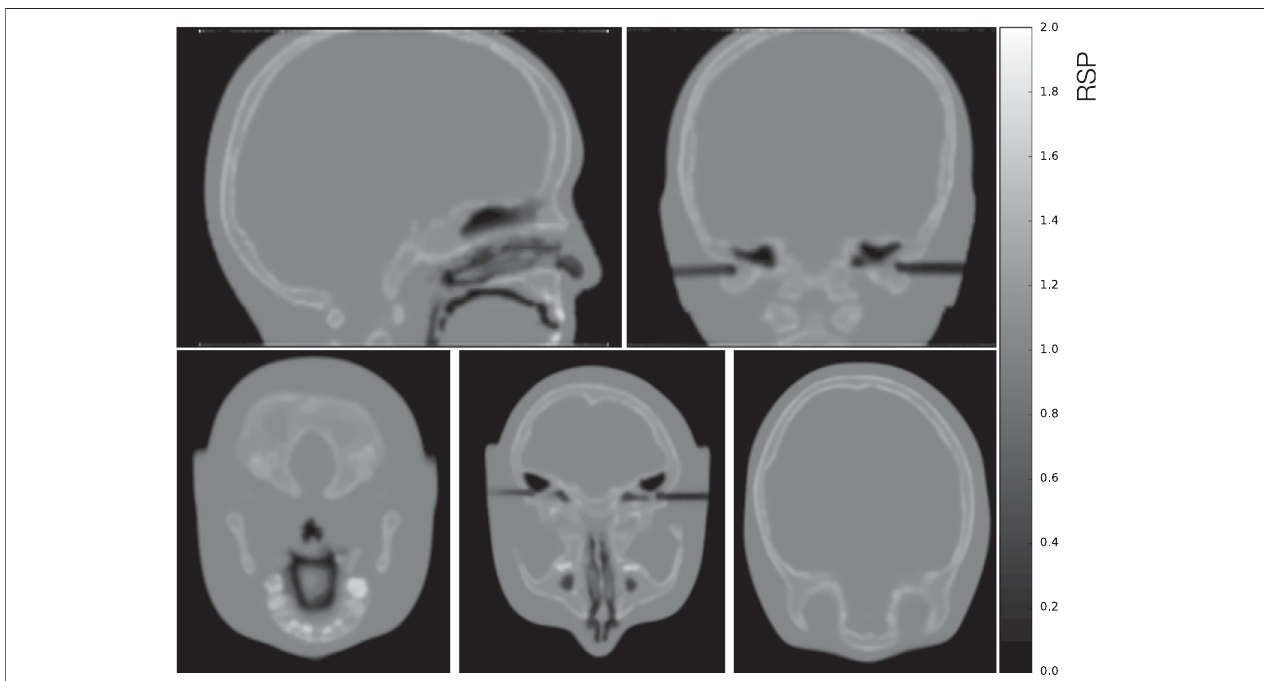
FIGURE 14 | From top left to bottom left clockwise: Sagittal, coronal, and three axial views of a full pCT reconstruction of the simulated head phantom in the modeled setup.